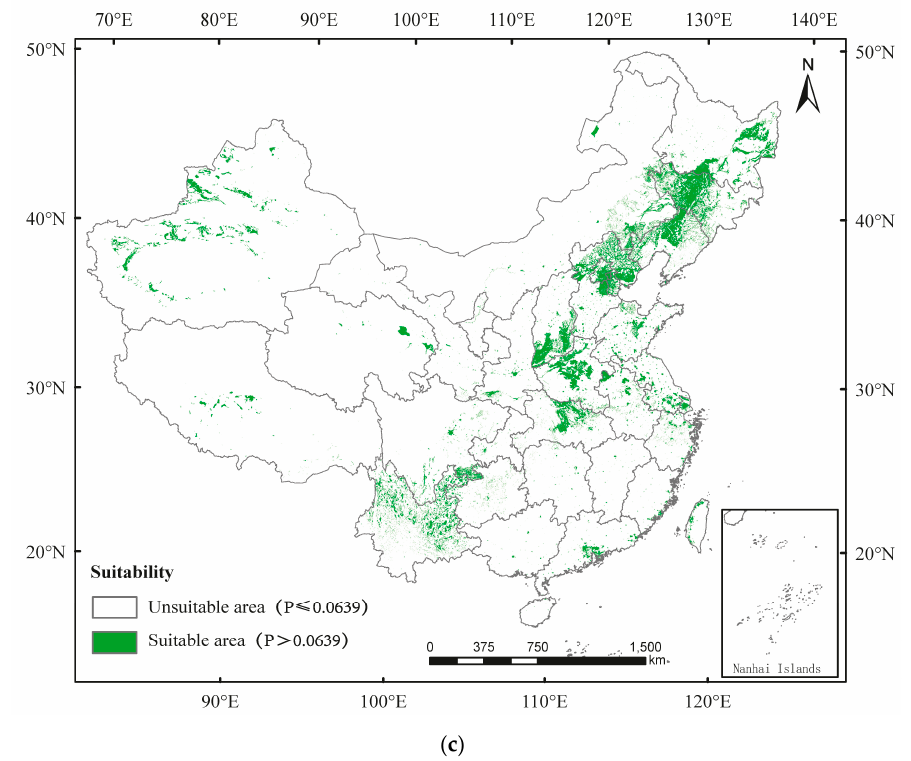
Figure 2. Potential distribution of Anoplophora glabripennis in China predicted using the MaxEnt model under ( a ) the current climate and according to climate change in ( b ) 2050 and ( c ) 2090.